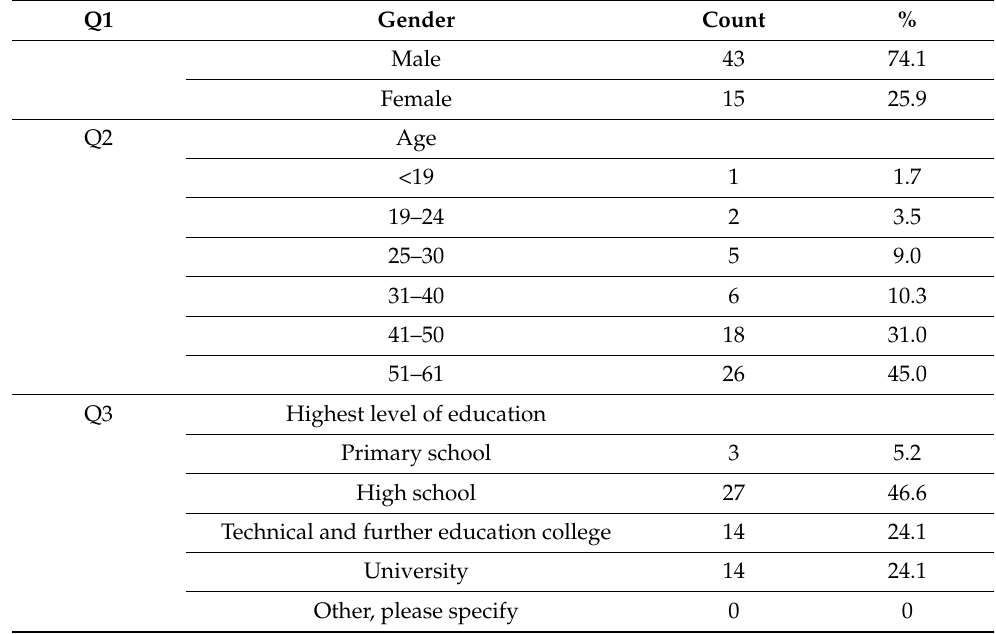
Table 6. Trainers’ ( n = 58) demographics in Study